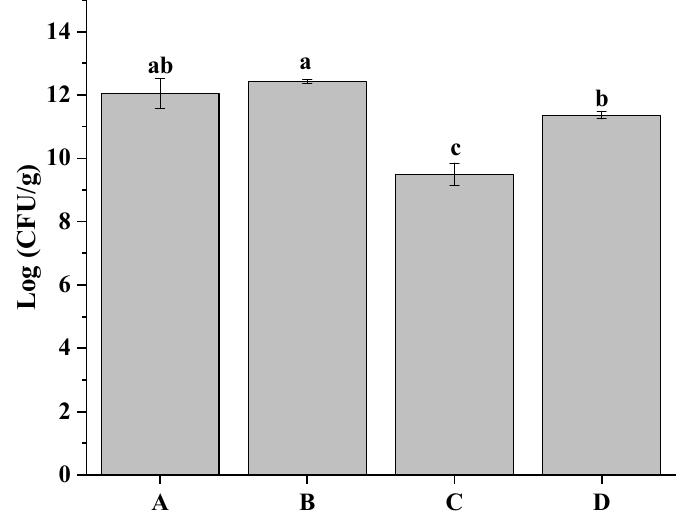
Figure 1. Effects of vacuum drying for 18–20 h (A), followed by equilibration to 0.75 a w for 20–24 h (B) and treatment with 365 nm (C) and 395 nm (D) light pulses emitted from the LEDs of dried and equilibrated S. Typhimurium ATCC13311, on the survival of S. Typhimurium cells. The 365 and 395 nm LED treatments of low-a w S. Typhimurium ATCC13311 were performed at 80% power level and at 4 cm from the LED head with the ~217 J/cm 2 dose corresponding to treatment times of 60 and 12 min, respectively. The results are represented as means ± standard deviation of three independent replicates. Values with different letters differ significantly ( p < 0.05).